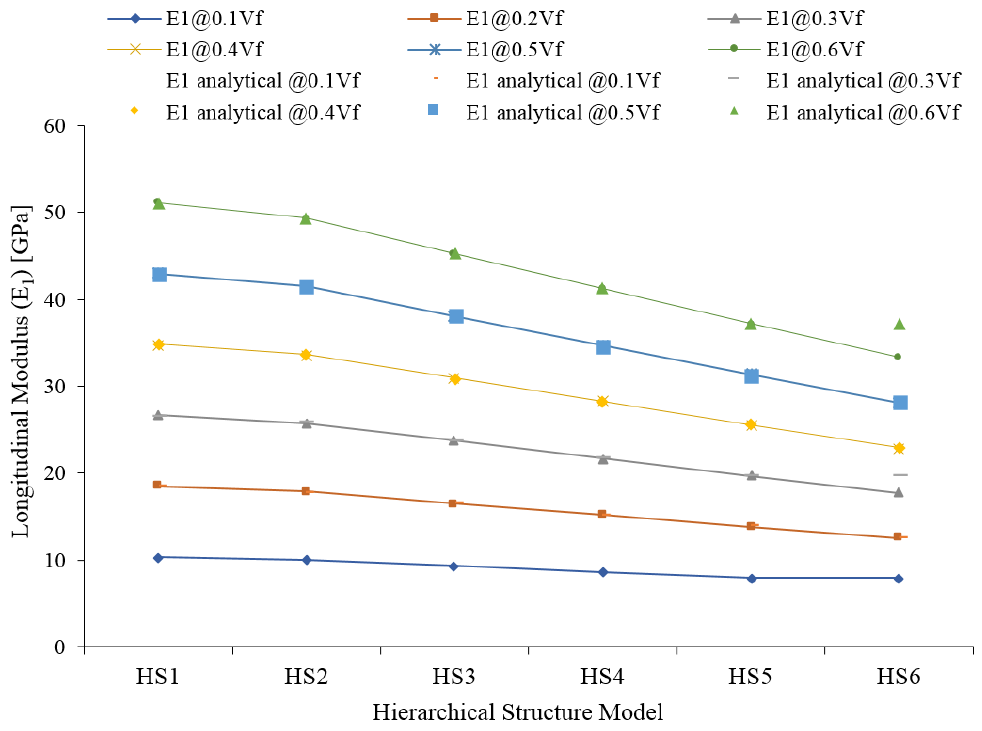
Figure 10. Longitudinal modulus (E 1 ) of jute fiber reinforced composite. Transverse Modulus (E 2 ) also decreased from HS-1 to HS-6 and at a higher volume fraction of JF; the property loss is high, whereas at lower volume fraction of JF the effect of HS is negligible (Figure 11). The main changing parameter of HS is the percentage of lumen in the structure, it increases from HS-1 to HS-6, and the increase of the percentage of lumen decreases the contribution of cellulose in the fiber as a result of the decrease of the modulus. The simulation results are compared with the analytical results, and both results are in good